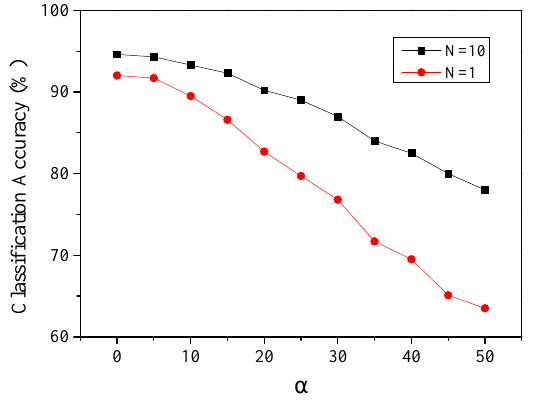
Figure 7. Impact of weight variations on classification